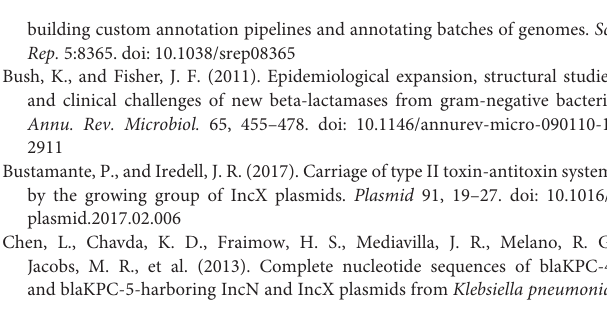
FIGURE S1 | Schematic maps of IncX6 plasmids. Genes are denoted by arrows, and the backbone and accessory module regions are highlighted in black and gray, respectively. The innermost circle presents GC-skew [(G − C)/(G + C)], with a window size of 500 bp and a step size of 20 bp. The next-to-innermost circle presents GC content. FIGURE S2 | Alignment of promoter-proximal regions of bla KPC - 2 . The 898–354 bp upstream sequences together with the start codon of the bla KPC - 2 genes from IncX6 plasmids and Tn 6296 are aligned by MUSCLE. Shown are core promoter regions, − 35 and − 10 elements, transcription starts, Shine-Dalgarno (SD) sequences for ribosome recognition and translation starts. TABLE S1 | KPC-producing Enterobacteriaceae